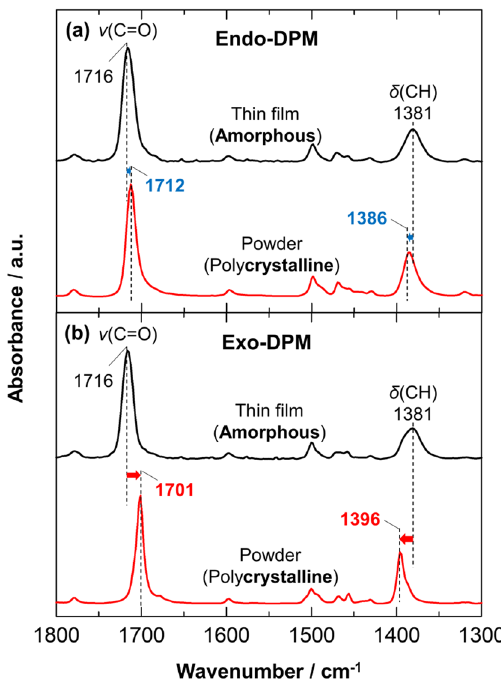
Figure 5. IR ATR spectra of polycrystalline powder samples of endo-DPM ( a ) and exo-DPM ( b ), and the orientation-free spectra of the amorphous films in Figs. 2 and